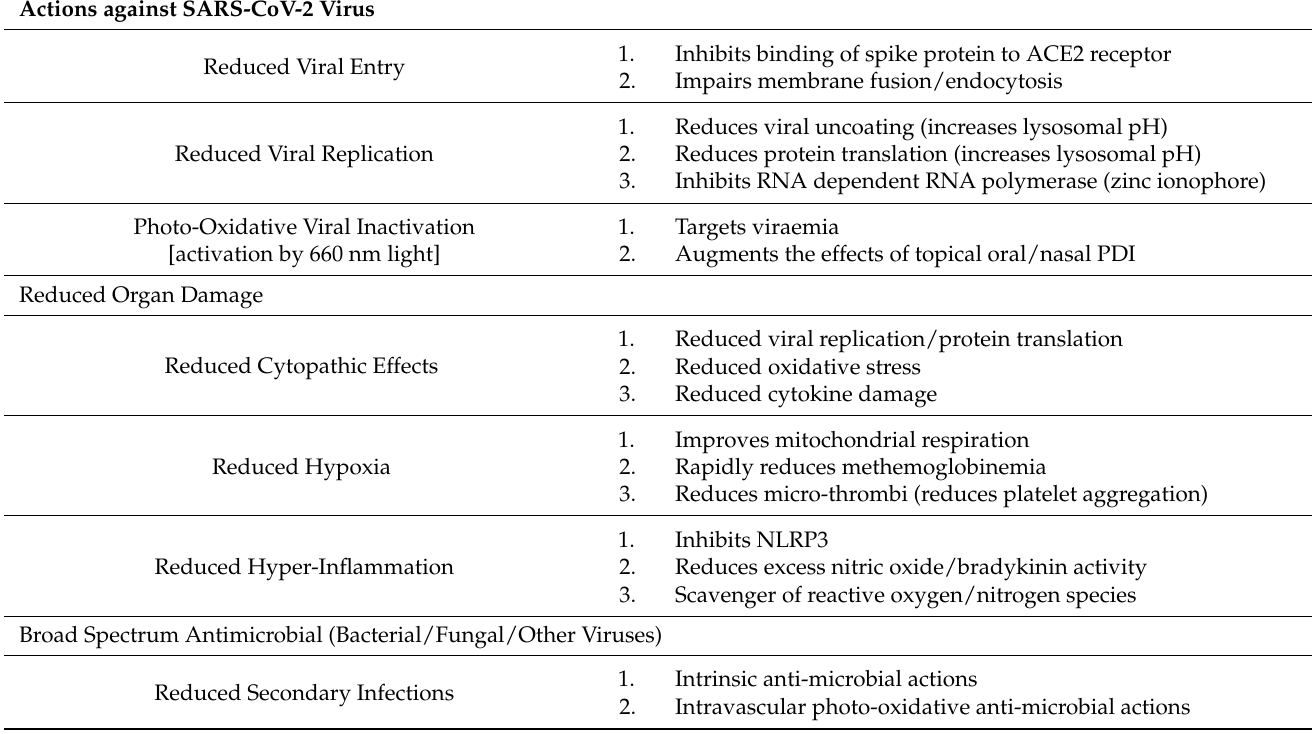
Table 1. Mechanisms of action of methylene blue (MB) in COVID-19 disease. Abbreviations: ACE2: Angiotensin-converting enzyme